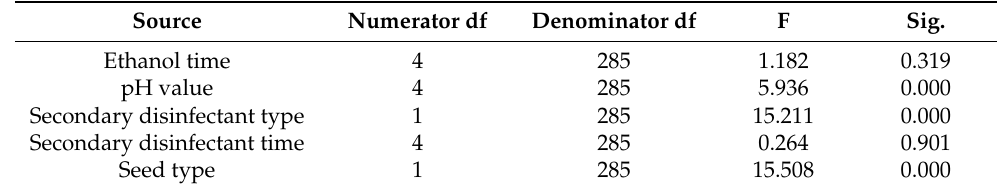
Table 4. A mixed model ANOVA on contamination percentage of dimorphic seeds of Suaeda aralocaspica